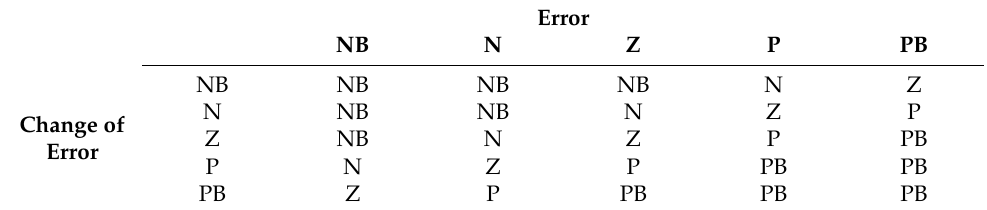
Table 2. Rules for the proposed controller.